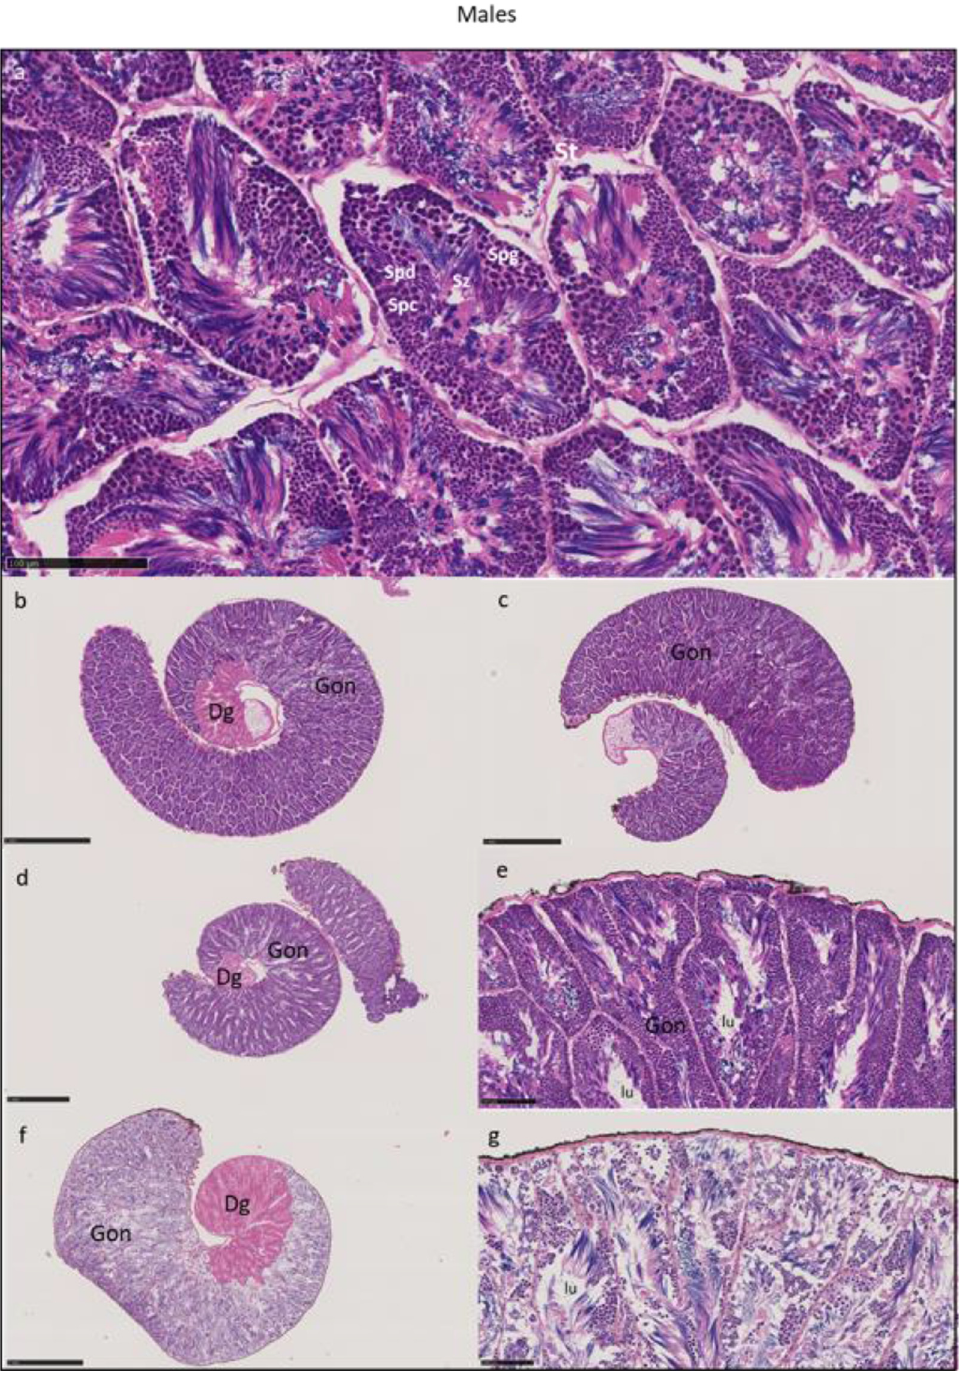
Fig. 8. T. mutabilis. Histological section of the gonads of males larger than 19 mm SH. (a 19 .4mm, b 20 .8, c 21.5mm, d 23mm, e